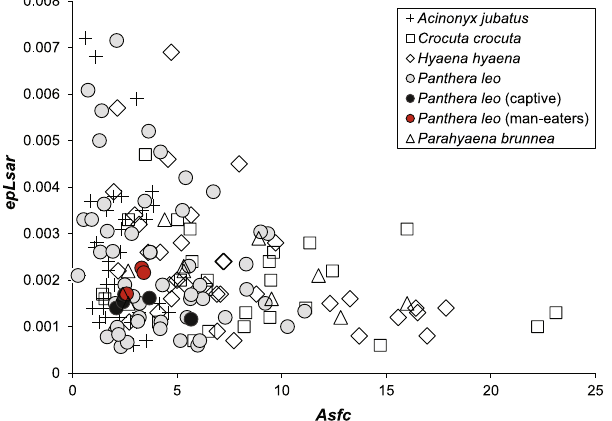
Figure 3. Bivariate plot of anisotropy ( epLsar ) and complexity ( Asfc ) of cheetahs, hyenas (multiple species), captive lions, man-eating lions, and wild-caught lions.